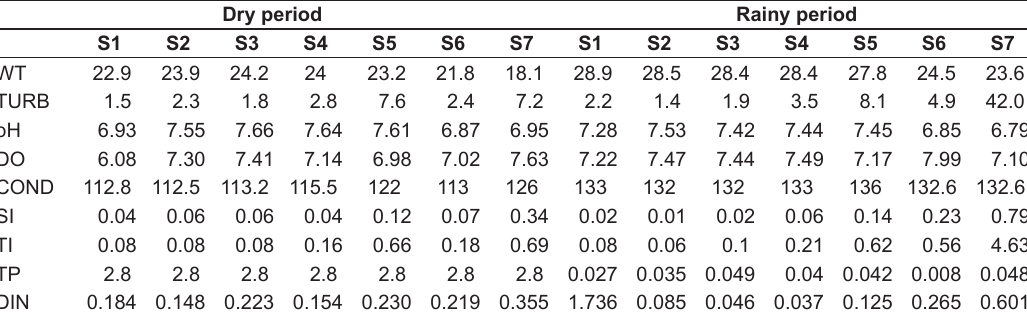
Table 1. Environmental variables sampled in the João Leite reservoir, GO, Brazil, during a dry and rainy period.